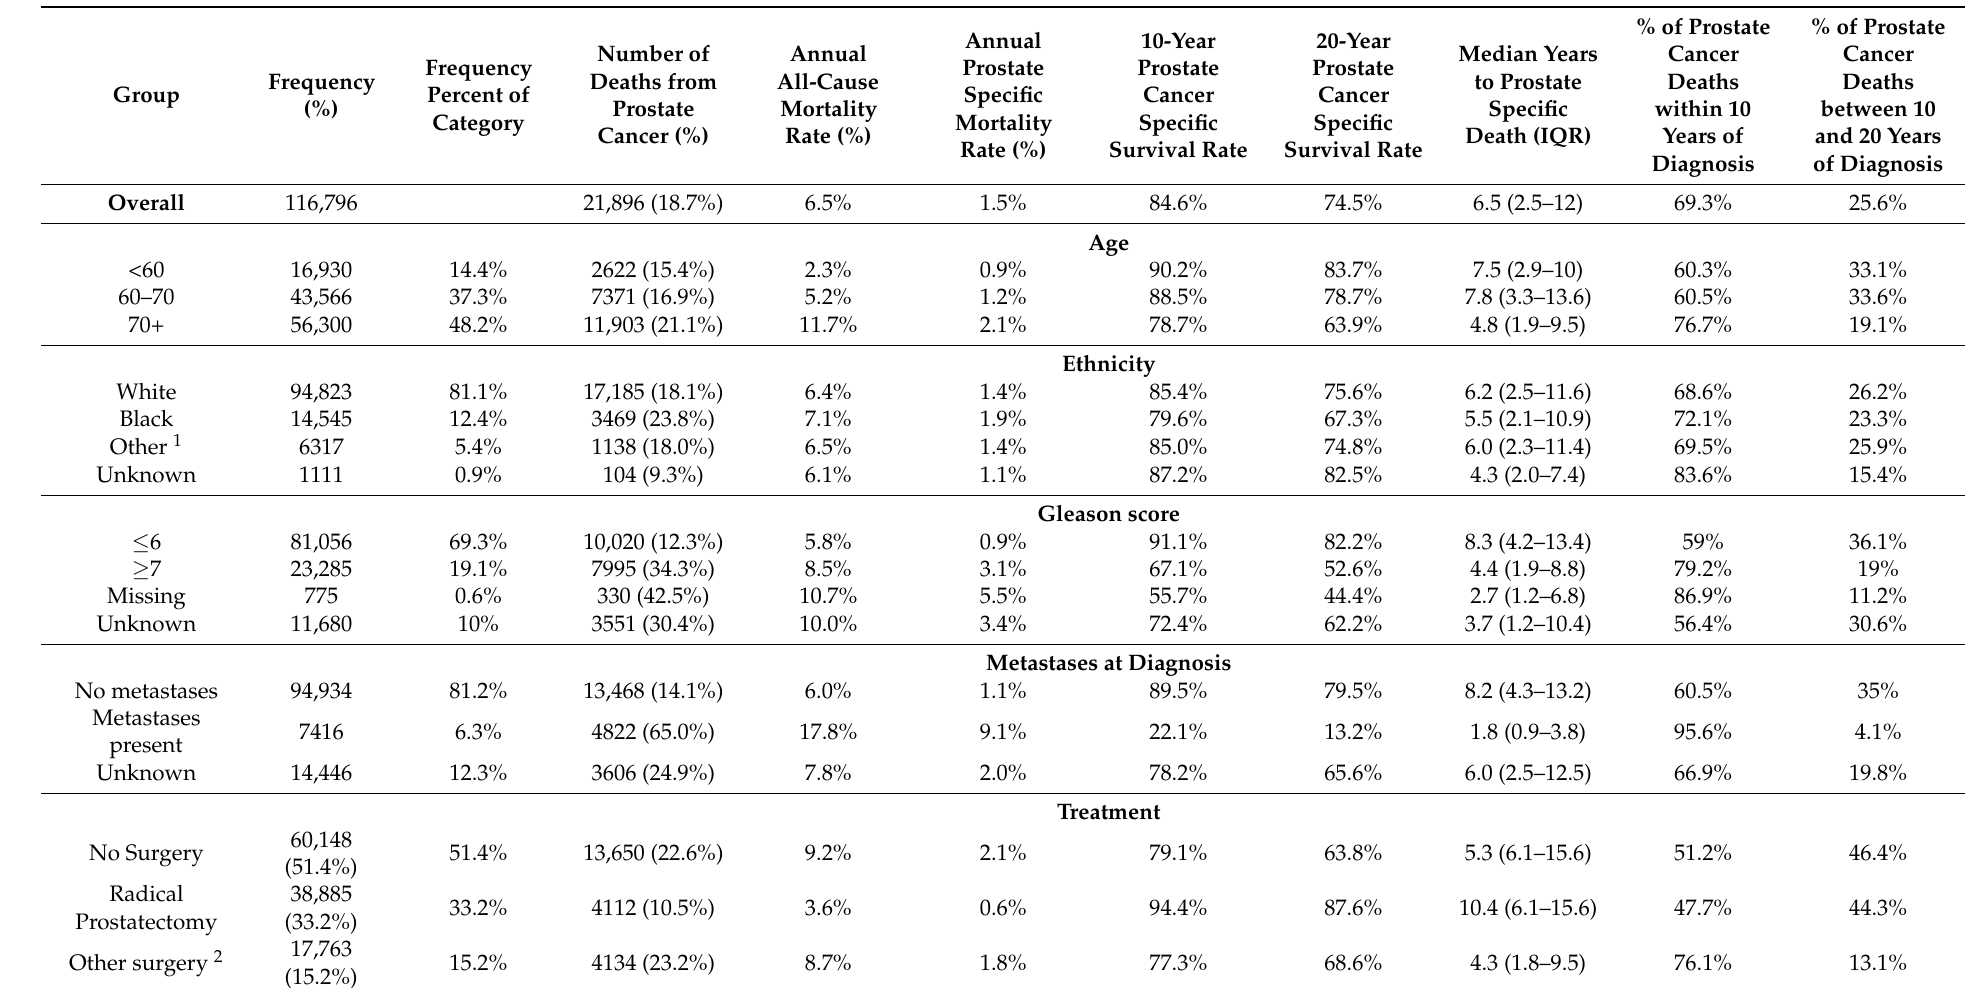
Table 1. Demographic information for entire